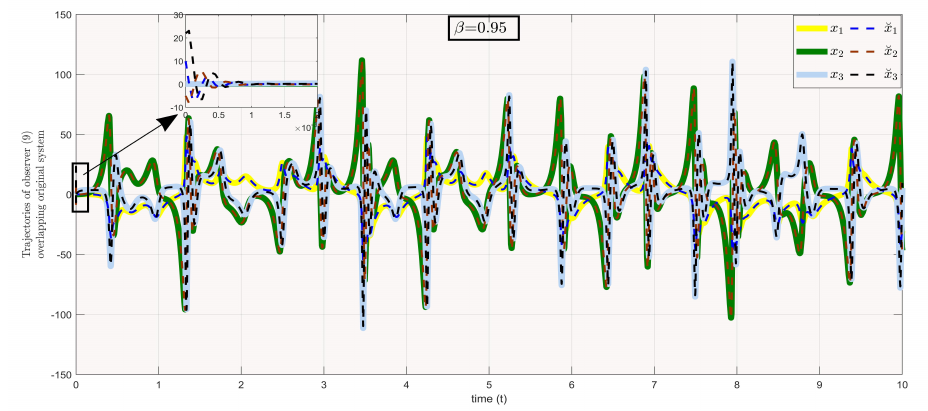
Figure 4. Trajectories of observer and fractional order Gyrostat chaotic